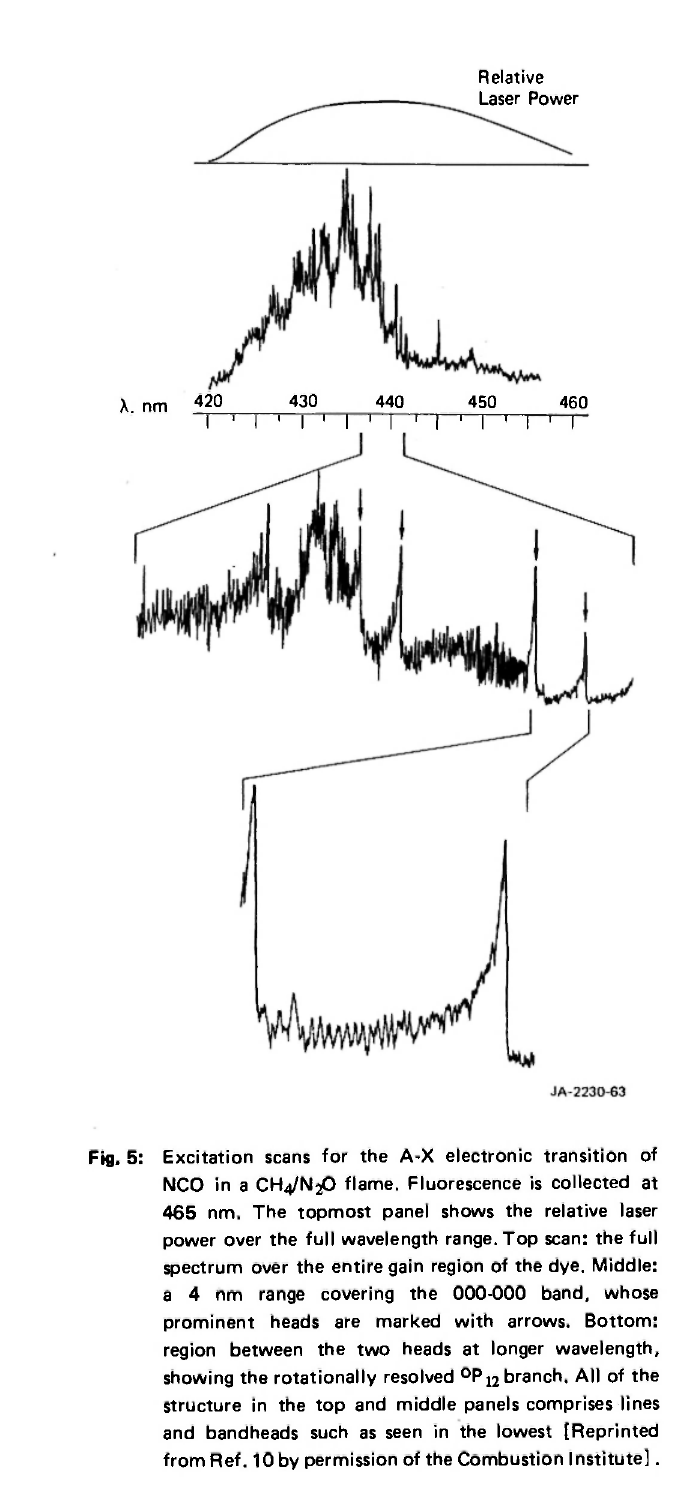
Fig. 5: Excitation scans for the A-X electronic transition of NCO in a CH^/NjO flame. Fluorescence is collected at 465 nm. The topmost panel shows the relative laser power over the full wavelength range. Top scan: the full spectrum over the entire gain region of the dye. Middle: a 4 nm range covering the 000-000 band, whose prominent heads are marked with arrows. Bottom: region between the two heads at longer wavelength, showing the rotationally resolved °P 12 branch. All of the structure in the top and middle panels comprises lines and bandheads such as seen in the lowest [Reprinted from Ref. 10by permission of the Combustion